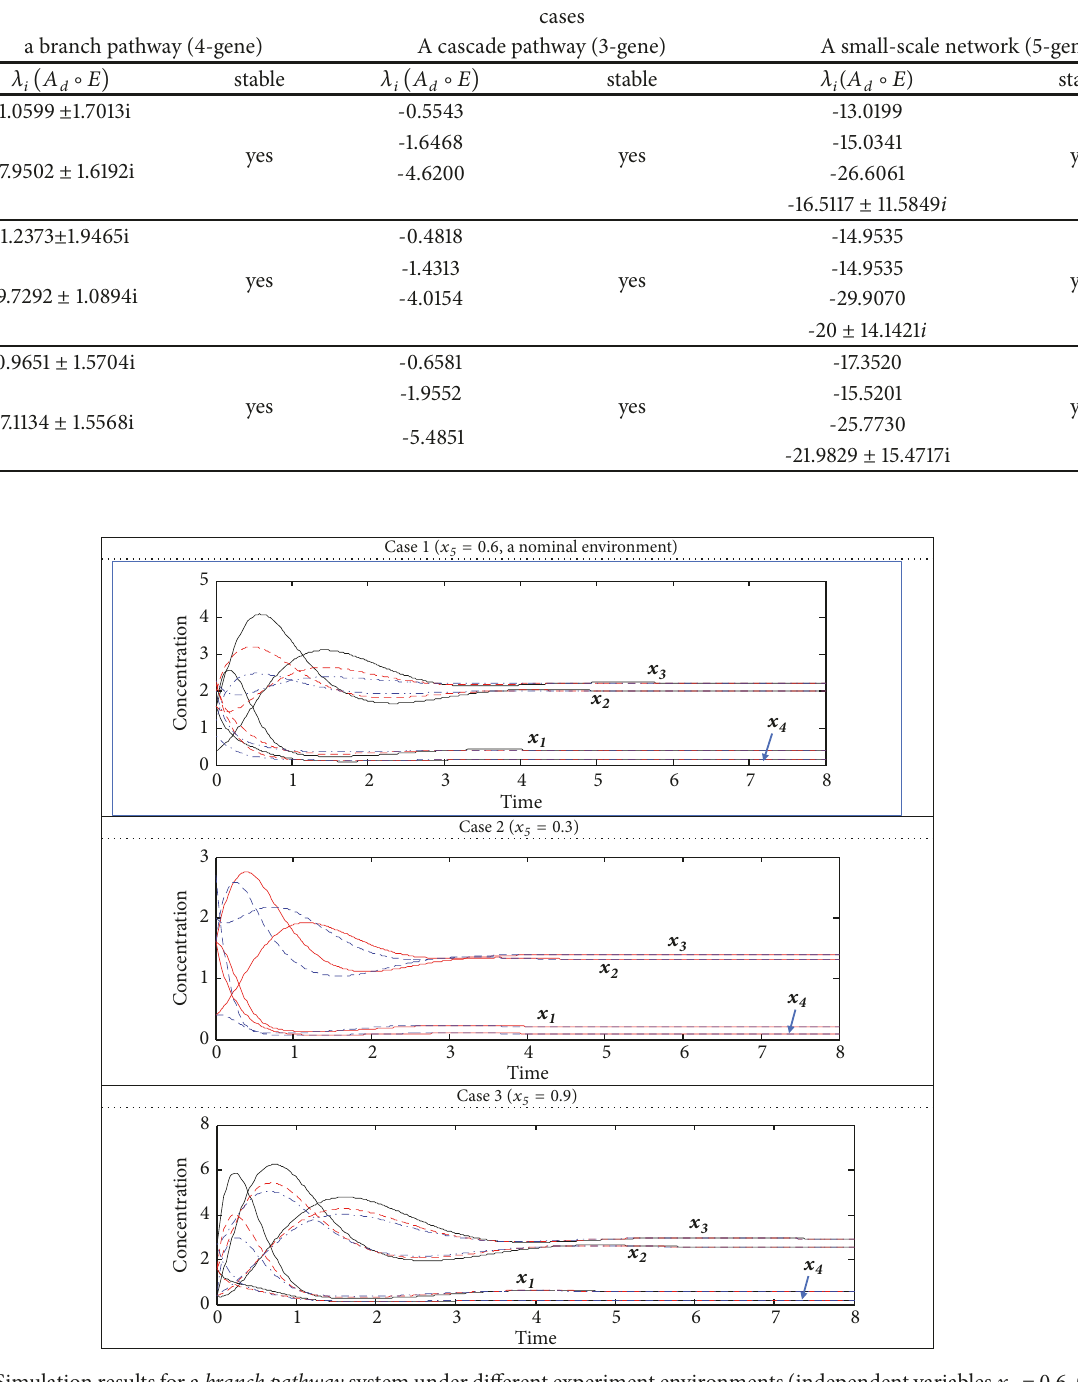
Table 4: Stability analysis for the three biological systems. The independent variables in the branch pathway is set at 𝑥 5 = 0.6 (Case 1), 0.3 (Case 2), and 0.9 (Case 3). The independent variable in the cascade pathway is set at 𝑥 4 = 0.75 (Case 1), 0.9 (Case 2), and 0.6 (Case 3). The independent variables in the small-scale network are set at (x 6 , x 7 , x 8 ) = (1, 0.75, 0.75) for Case 1, (1, 1, 1.25) for Case 2, and (1.25, 1.25, 1.25) for Case 3.